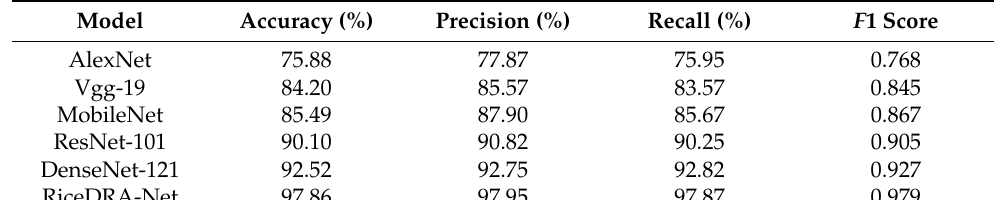
Table 7. Comparison of various classical models under CBG-Dataset.